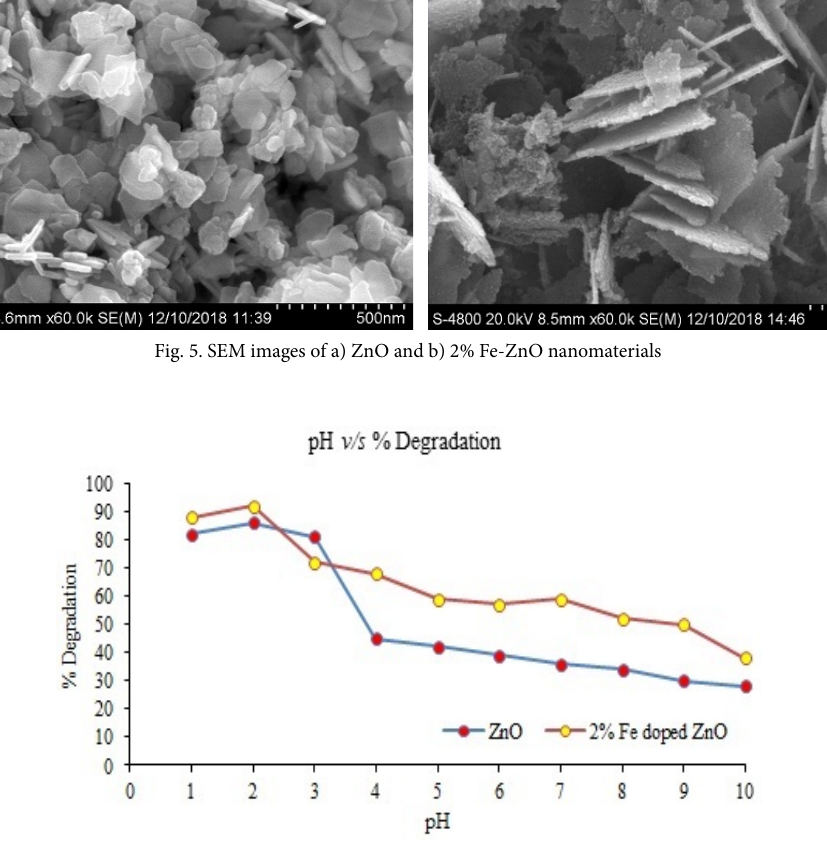
Fig. 6. Effect of pH on photocatalytic degradation of MB dye under conditions: pH= 1-10, dye concentration 20 mg/L and catalyst (ZnO and 2% Fe- ZnO) dose 1 g/L for the irradiation time 180 min.